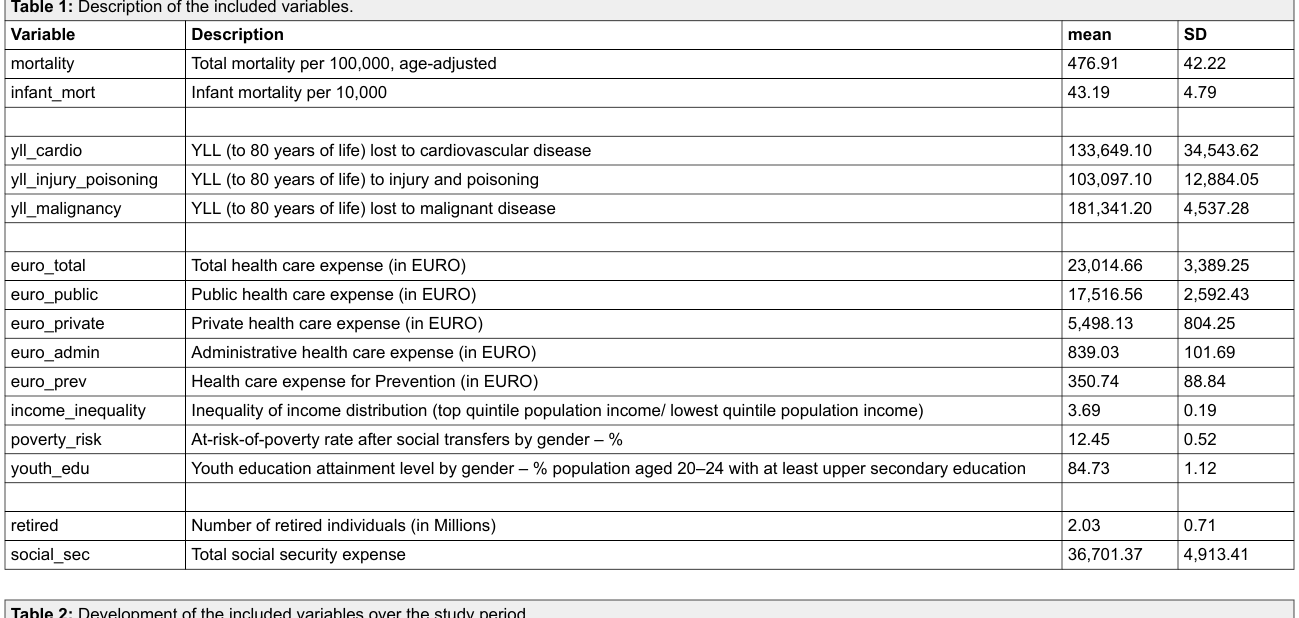
Table 2: Development of the included variables over the study